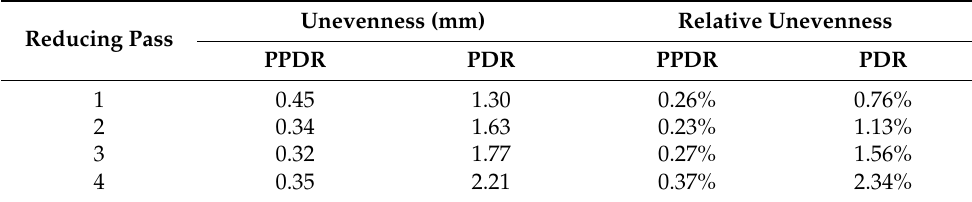
Table 8. Comparison of unevenness.